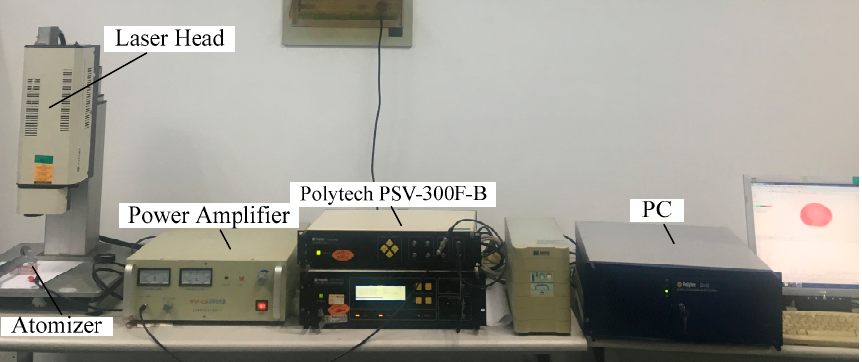
Figure 6. A photograph of measuring the vibration mode of the piezoelectric vibrator.